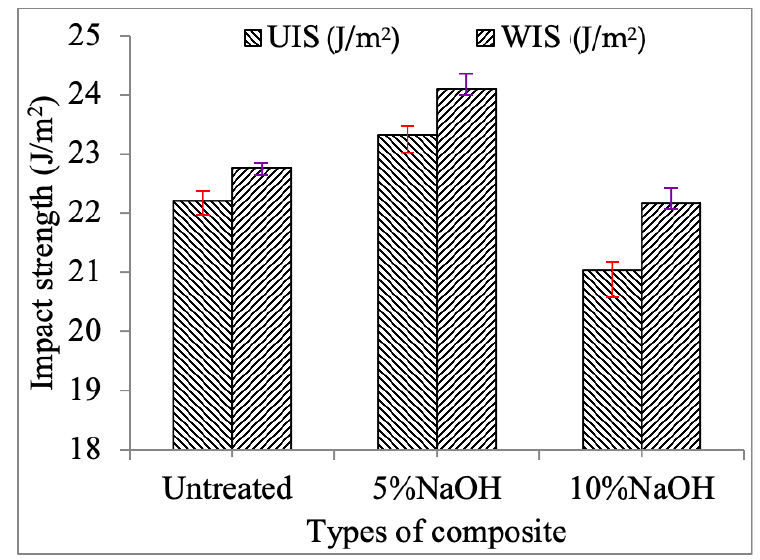
Figure 6. The impact strength of unidirectional (UIS) and woven (WIS) composites. Although a strong binding must be guaranteed to produce materials for interior and structural applications, a weak interfacial link increases toughness by encouraging pullout effects required for energy absorption or impact strength purposes. For this reason, the 5% NaOH-treated composite has greater impact strength than the 10% NaOH-treated and untreated hybrid